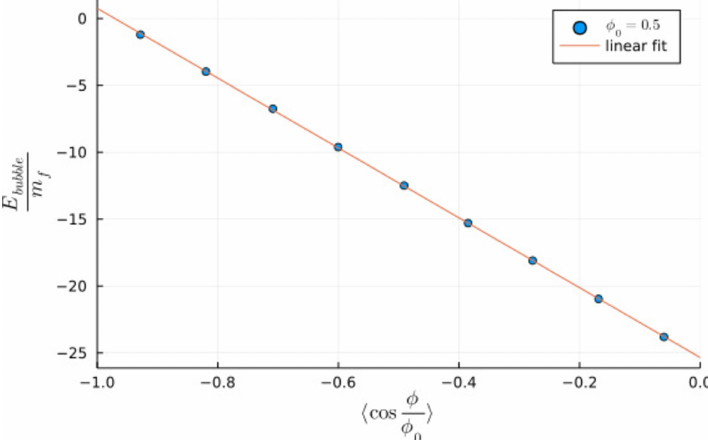
i . The simulation φ 0